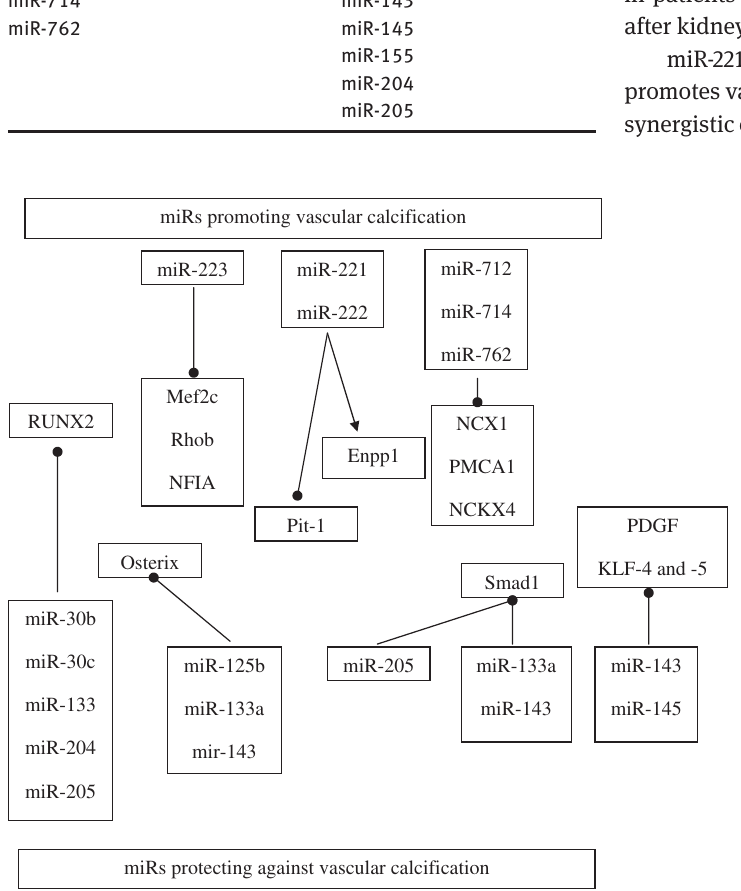
Figure 1: Molecular pathways mediating the effects of microRNAs (miRs) on vascular calcification. RUNX2, Runt-related transcription factor 2; Mef2c, myocyte enhancer factor 2c; NFIA, nuclear factor IA; Pit-1, type III sodium-dependent Pi cotransporter-1; Enpp1, ectonucleotide phosphodiesterase; NCX1, sodium/calcium exchange member 1; PMCA1, plasma membrane calcium pump isoform 1; NCKX4, sodium/potassium/calcium exchange member 4; PDGF, platelet-derived growth factor; KLF, Krüppel-like factor. Stimulation;